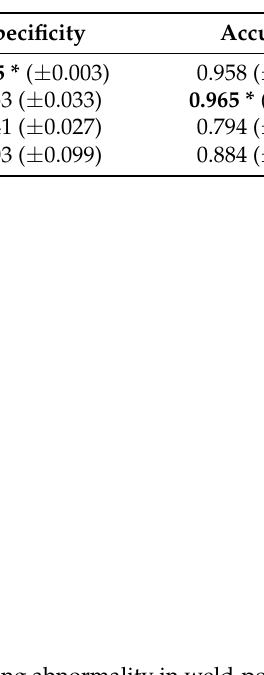
Table 3. Performance of classification of abnormality in weld-pool/bead.